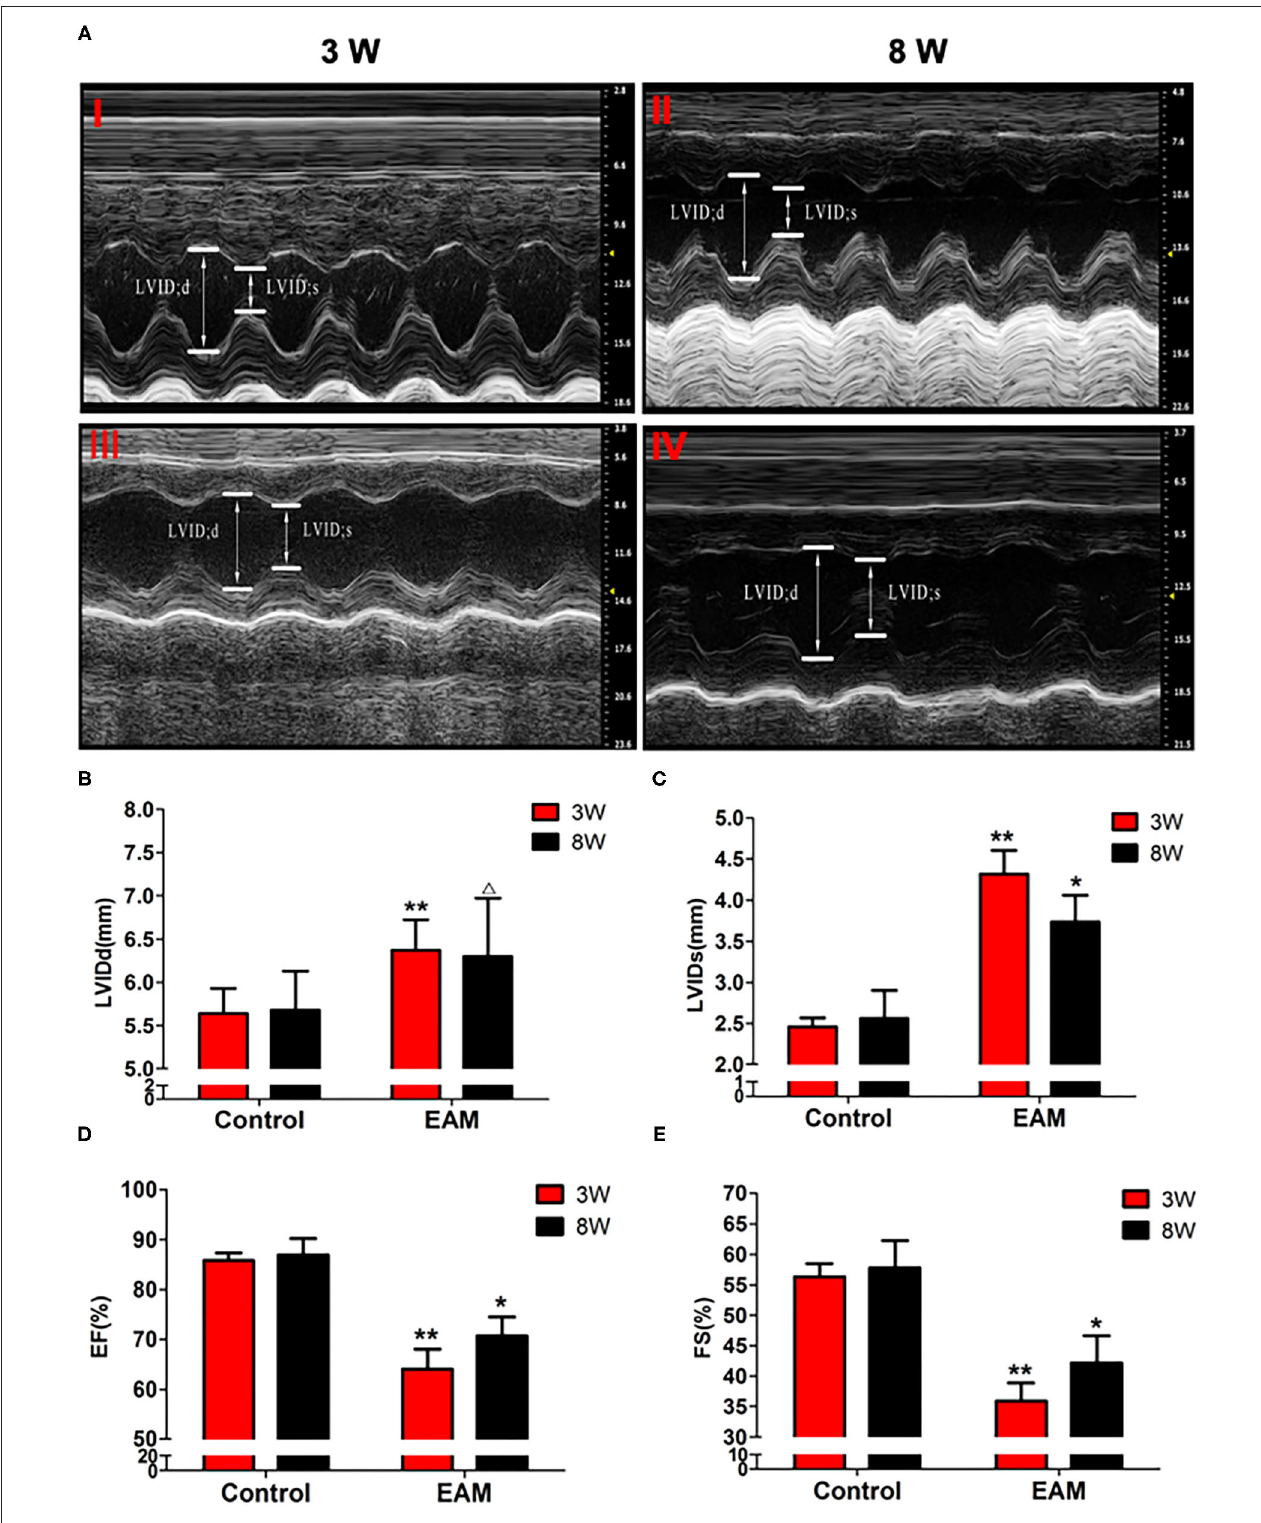
FIGURE 2 | The level of LVIDd/LVIDs/EF/FS in “early” and “late” stages of myocarditis in control and EAM mice by echocardiography. (A) Control groups (top panel, 3W, I; 8W; II) and EAM mice (bottom panel, 3W,I II; 8W, IV). (B–E) Quantification of LVIDd (B) , LVIDs (C) , EF (D) , and FS (E) in “early” and “late” stages of myocarditis from control groups and EAM mice. n = 4 rat in control group, n = 5 rat per group (B–E) . All data are presented as mean ± SEM; a Student’s t -test was performed to control group and EAM group. * p < 0.05 vs. control group; ** p < 0.01 vs. EAM + DMSO group; 1 p > 0.05 vs. EAM group.